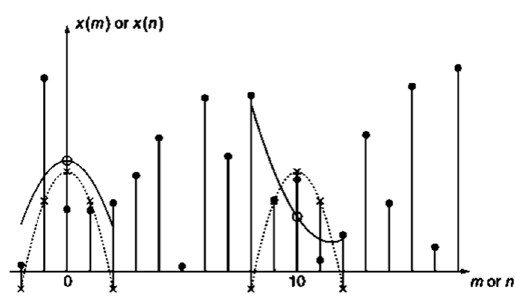
Figure 5. Diagram of the least-squares polynomial fit in the Savitzky–Golay (SG) filter